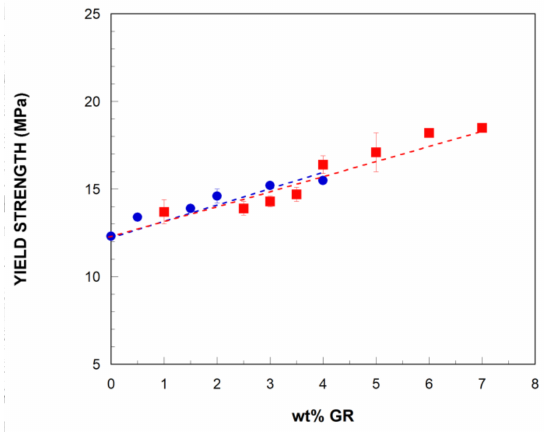
Figure 6. The yield strength of the bTPU/GR ( (cid:4) ) and bTPU/GR-IL ( • ) NCs as a function of the GR content.